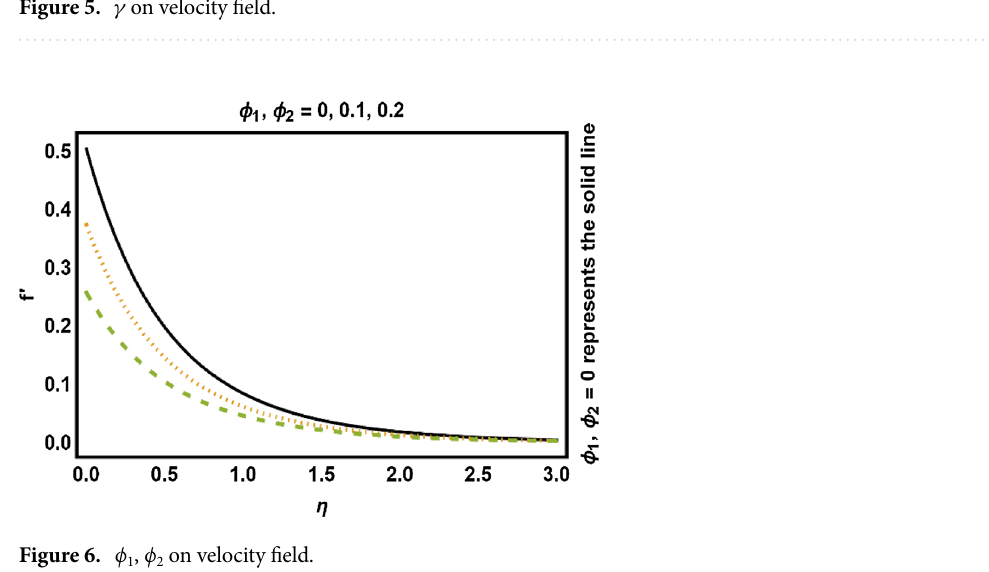
Figure 6. ϕ 1 , ϕ 2 on velocity